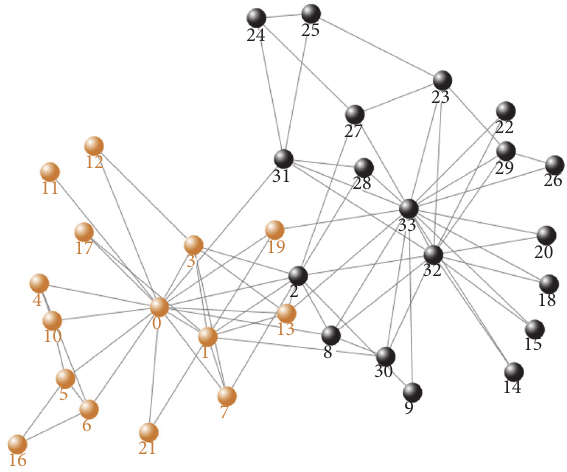
Figure 8: The result of NewLCD algorithm on Karate.